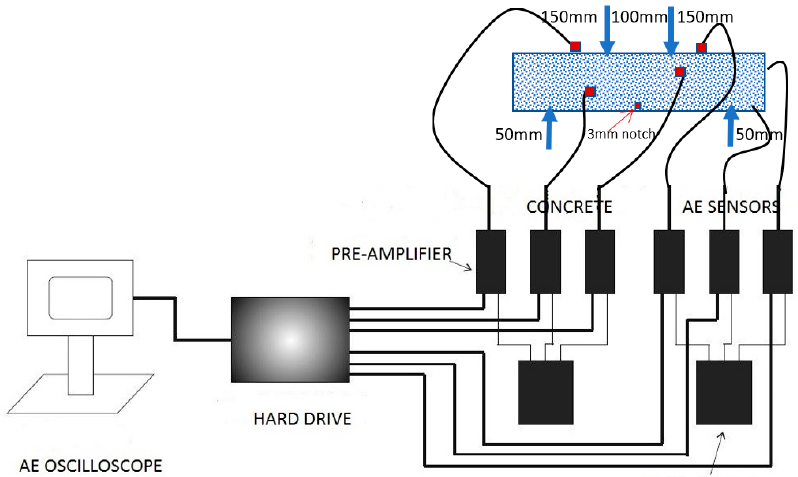
Figure 5. Acoustic emission and four-point bending test setup.